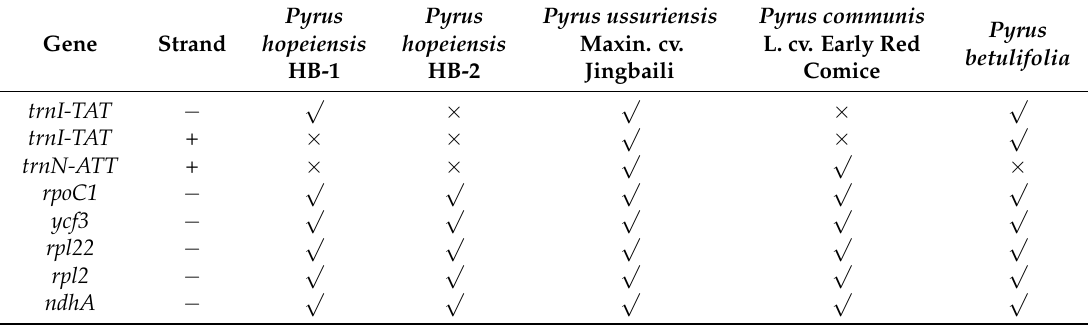
Table 3. Statistics of gene introns in the chloroplast genome of five Pyrus species. Pyrus Pyrus hopeiensis hopeiensis Gene Strand Maxin. HB-1 HB-2